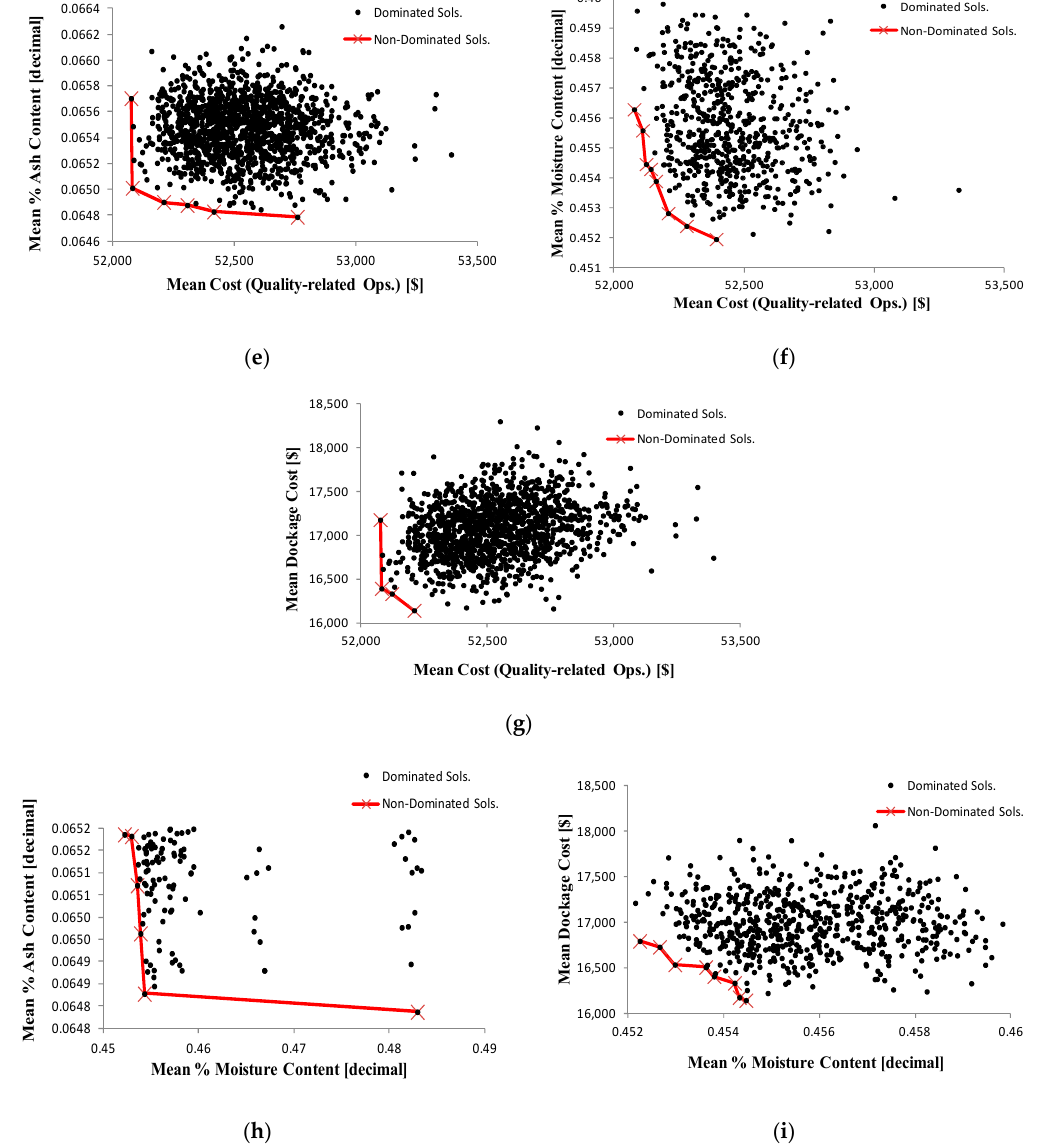
Figure 9. Pareto fronts (schedule (*)): ( a ) mean DMLOSS vs. mean cost; ( b ) mean DMLOSS vs. mean percent moisture; ( c ) mean DMLOSS vs. mean percent ash; ( d ) mean DMLOSS vs. mean dockage cost; ( e ) mean cost vs. mean percent ash; ( f ) mean cost vs. mean percent moisture; ( g ) mean cost vs. mean dockage cost; ( h ) mean percent moisture vs. mean percent Ash; and ( i ) mean dockage cost vs. mean percent moisture.